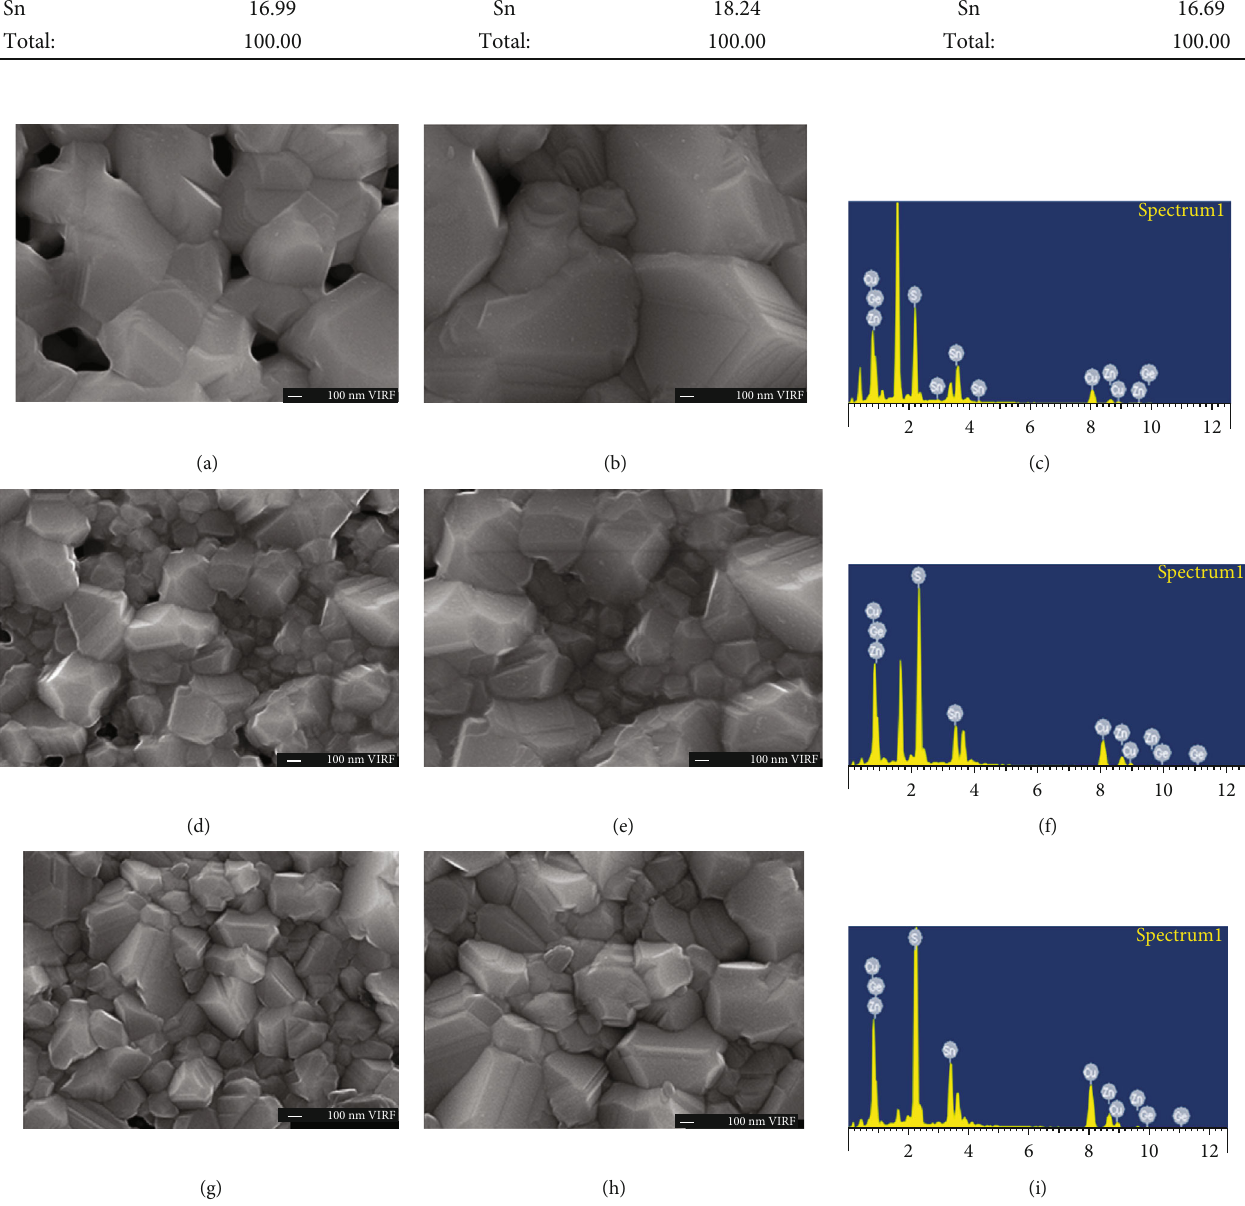
Figure 4: (a – i) FE-SEM and EDS patterns for the CZGTS, CZGTS-PVA, and CZGTS-DMSO thin fi tallographic planes (002), (101), (200), (220), and (311). The measurement for the fabricated thin fi lms, as illustrated in week crystallographic (002) peak is suppressed su ffi ciently/or Figure 5. All six thin fi lms exhibited the prime CZTS strong almost disappear in Ge-alloyed CZTS thin fi lms, while the crystallographic peak corresponding to (112) plane at 2 θ (220) and (311) crystallographic plane peaks are slight shift value 28 ° , along with other week CZTS characteristic peaks toward the higher angle side for the CZGTS, CZGTS-PVA, at 2 θ values 16 ° , 18 ° , 33 ° , 47 ° , and 56 ° , corresponding to crys-